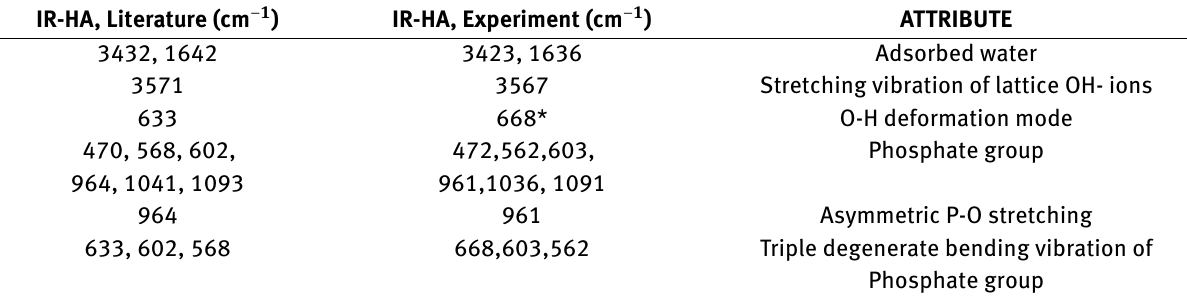
Table ST1: Comparison of the assigned FT-IR peaks for the various functional groups of the synthesized hydroxyapatite versus the reference HA sample’s values from literature [S1]